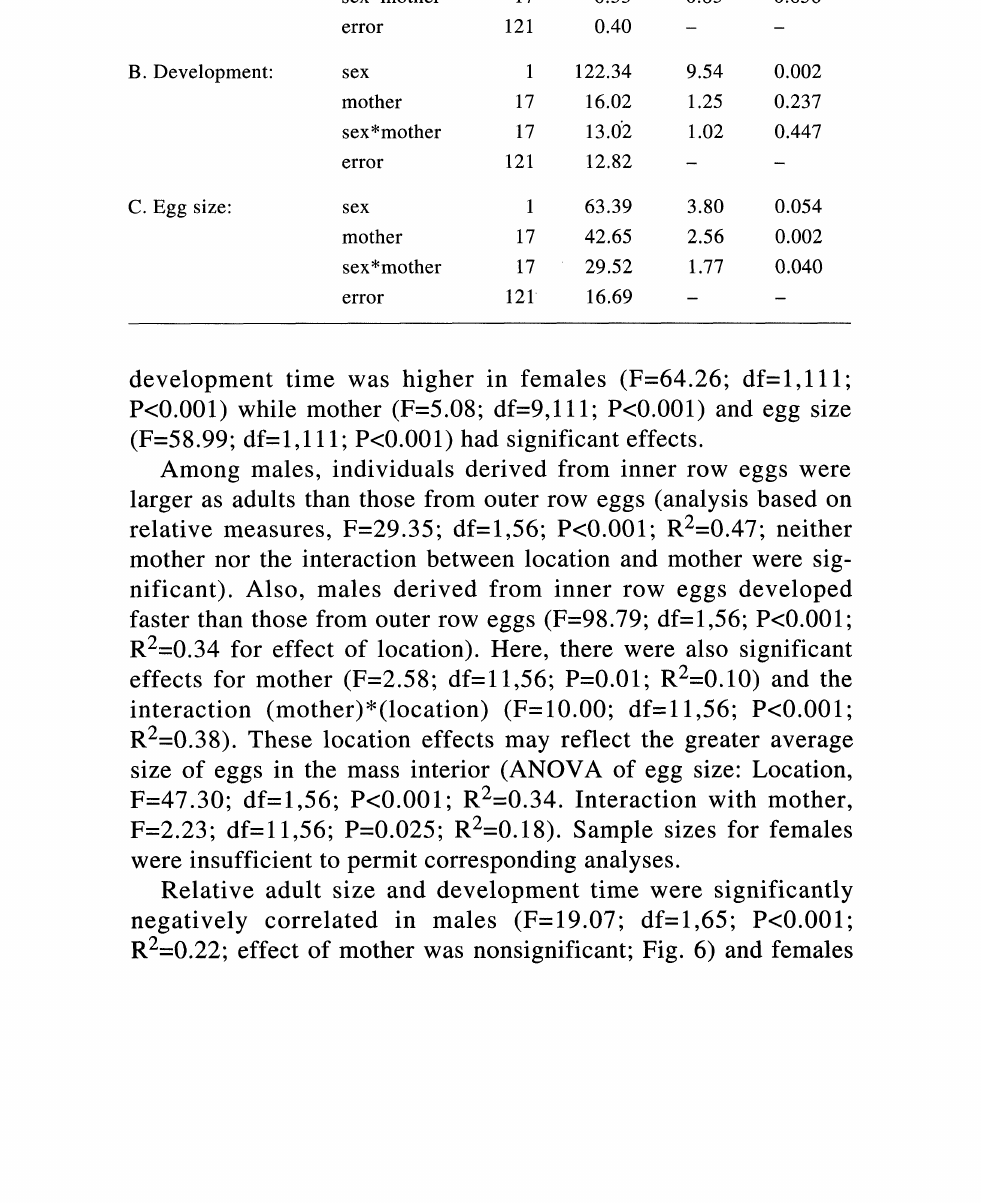
Table 3. ANOVA of effect of sex and mother on progeny traits: (A) adult size, (B) development time, and (C) egg size. Source of Variation DF MS F